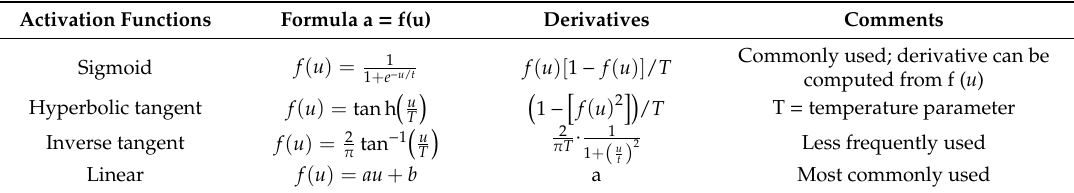
Table A1. Summary of neural network activation